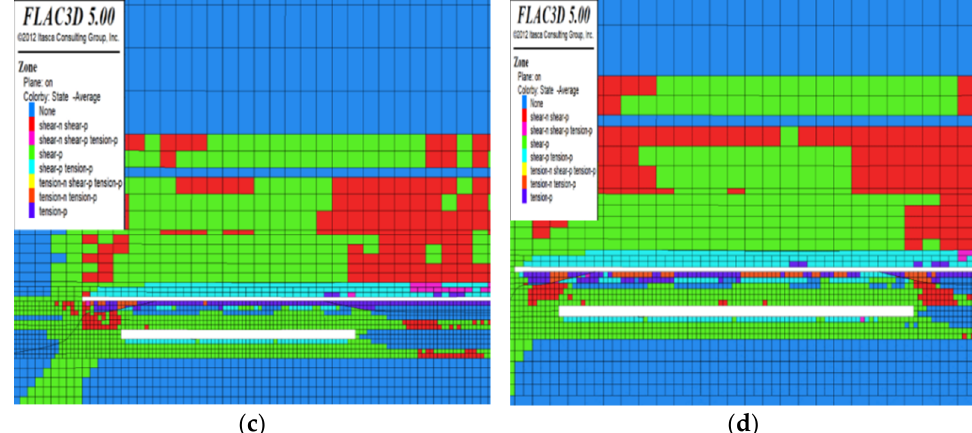
Figure 12. Plastic zone of coal seam #9 with different advancing distances. ( a ) Advancing 20 m. ( b ) Advancing 40 m. ( c ) Advancing 60 m. ( d ) Advancing 80 m.